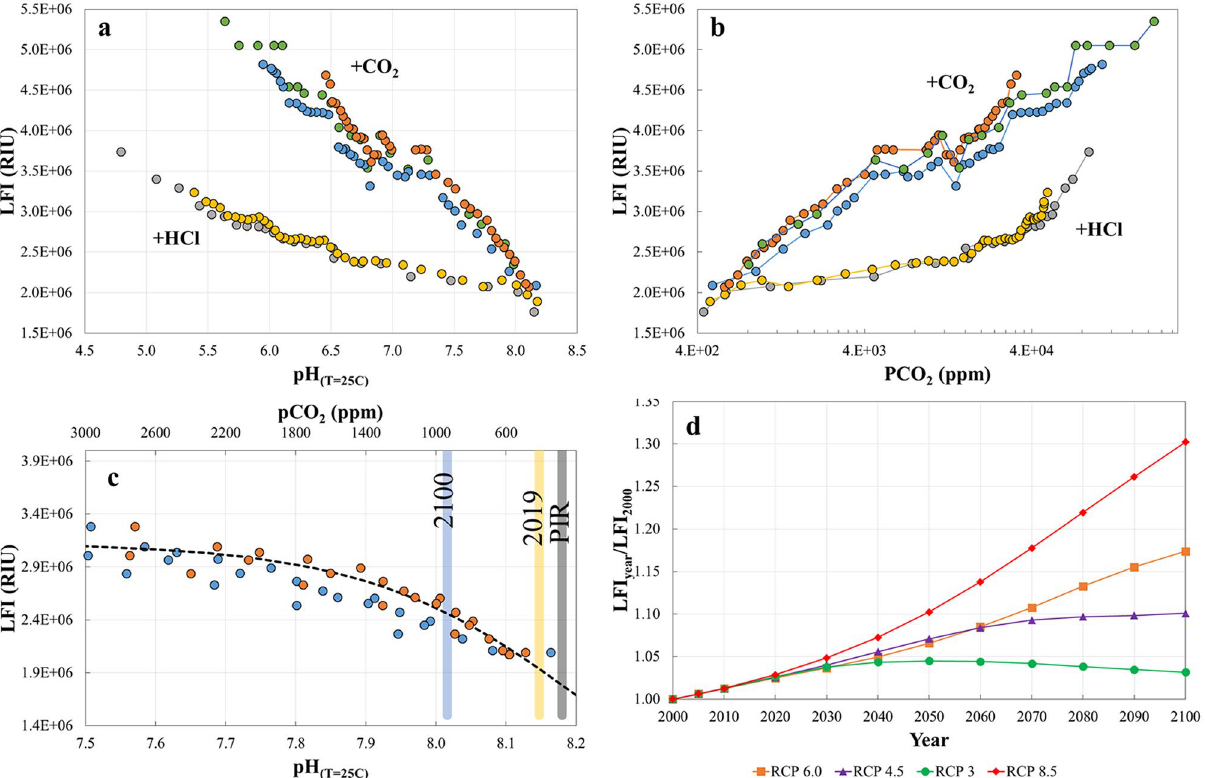
Figure 1. ( a ) Dependence of LFI on seawater pH adjusted to a constant temperature of 25 °C, and ( b ) calculated values of pCO 2 (calculated from pH and total alkalinity measurements at 25 °C), and ( c ) Change in LFI with pH and pCO 2 from their pre-industrial levels (PIR in the plot) up to pCO 2 = 3000 ppm and pH = 7.5, and ( d ) the ratio of calculated LFIs as a function of predicted atmospheric pCO 2 according to RCP 3, 4.5, 6.0 and 8.5 compared to LFI in 2000 at 25 °C. In panels a and b , the different colored markers correspond to different experiments and treatments indicated by + HCl (addition of strong acid experiments) and + CO 2 (CO 2 bubbling experiments). In addition each data point represents an average of 8–10 repeated measurements of the emission spectra with a standard deviation of ± 4% (maximum). In panel c all data from the 3 CO 2 bubbling experiments in the relevant range are included and the black dashed curve indicates the best fit of the logistic model (Eq. 1) to the LFI and corresponding pCO 2 data (n =